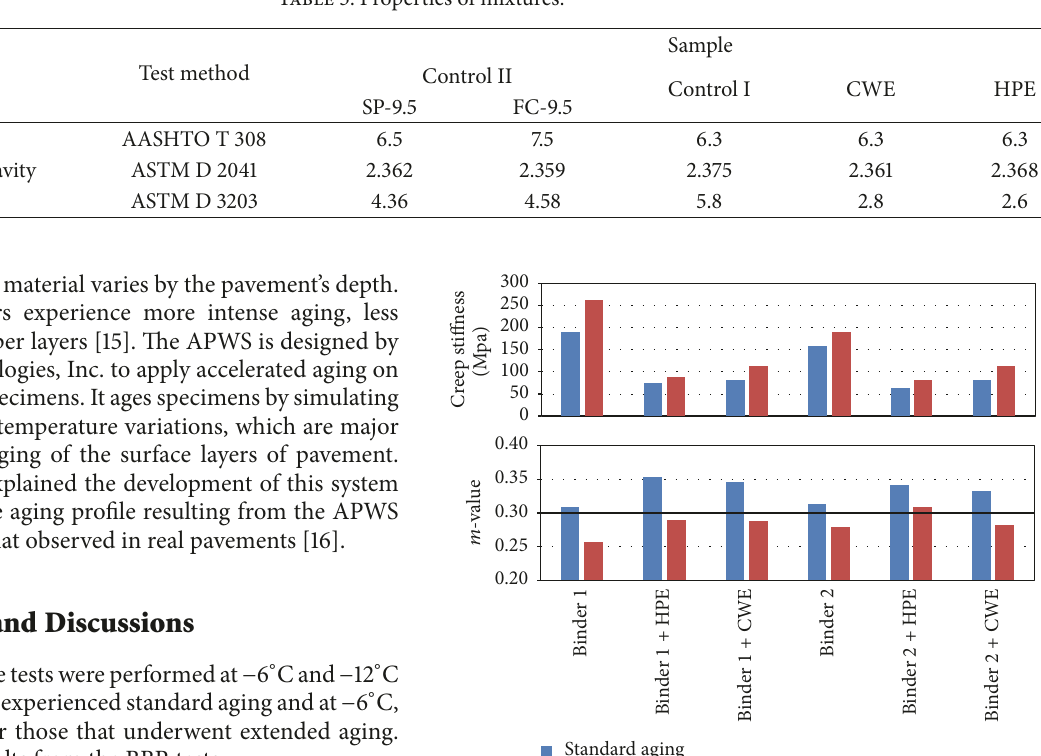
Table 3: Properties of mixtures.